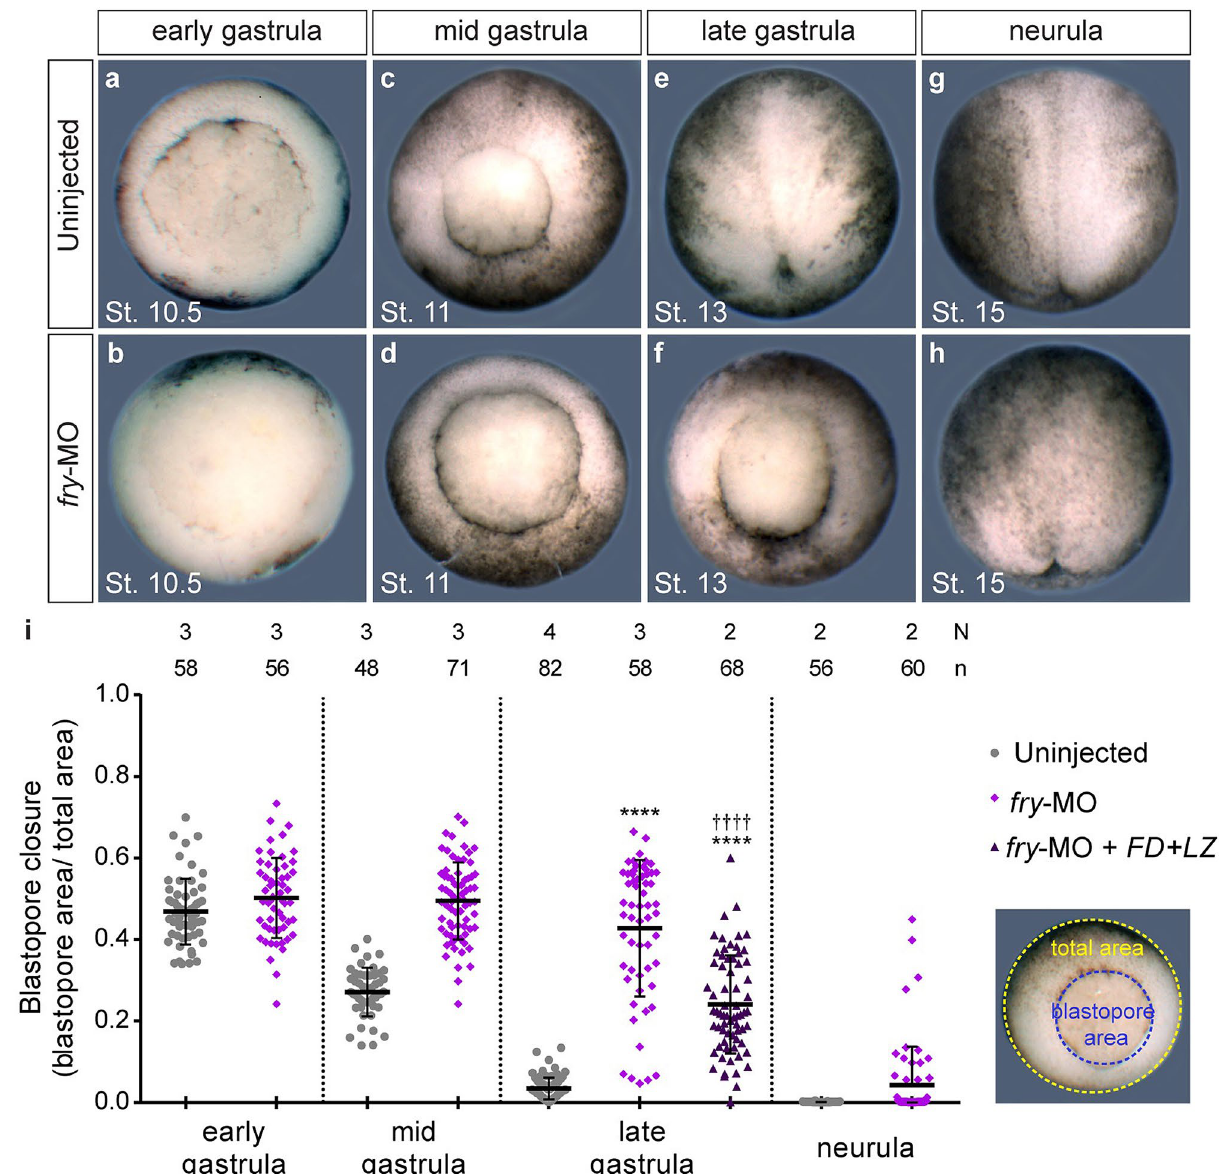
Figure 3. Fry is required for normal blastopore closure. ( a – h ) Uninjected or fry -MO (15 ng) injected embryos were fixed at the indicated gastrulation stage for blastopore closure measurements. Representative embryos for each stage are shown. Gastrula stage embryos are oriented dorsal to the top and neurula stage embryos are oriented anterior to the top. ( i ) Left: Quantification of the blastopore closure measurements on fixed uninjected embryos, fry -MO (15 ng) injected embryos and fry -MO (15 ng) + FD + LZ mRNA (800 pg) co-injected embryos at the indicated gastrulation stage. Right: Image showing the blastopore area (blue) and the area of the vegetal hemisphere of the embryo (total area, yellow). The ratio of these two measurements is plotted. 0 = blastopore closed. N: number of independent experiments, n: number of embryos. The stage of injected embryos was established based on the stage of uninjected control embryos. Means and standard deviation are indicated. Each point represents a single fixed embryo. Statistical significance was evaluated using Kruskal–Wallis test and Dunn’s multiple comparisons test (****, †††† p < 0.0001). * represents the comparison to the uninjected group and † represents the comparison to the fry -MO injected